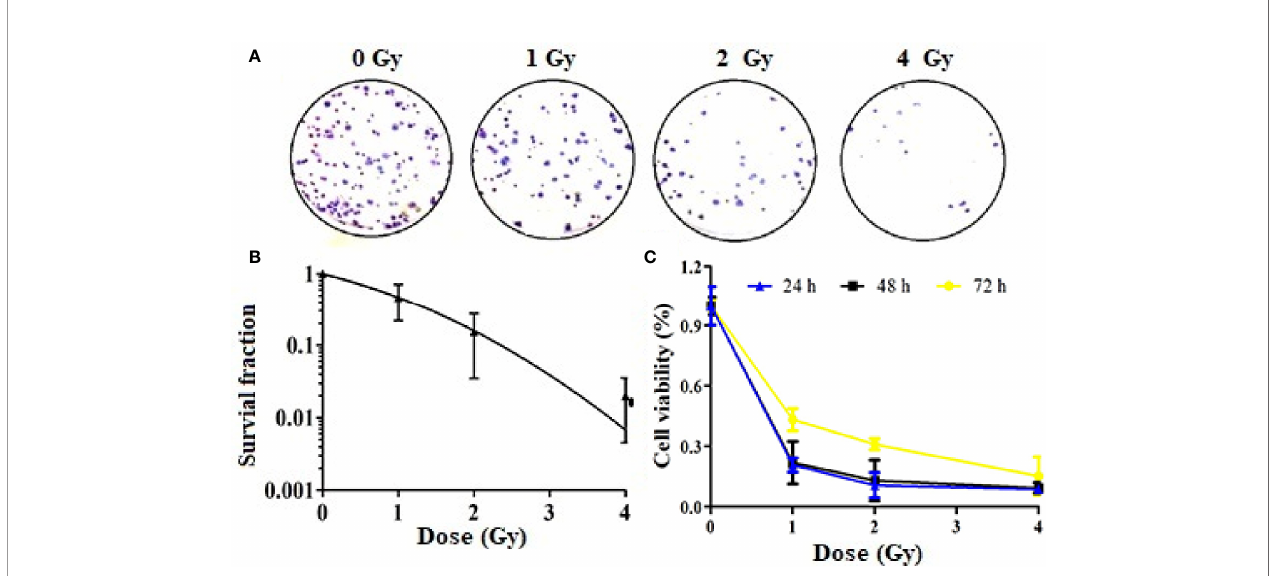
FIGURE 1 | Inhibition of Colony formation and proliferation of A549 cells by carbon ions [ (A) colony formation, (B) survival fraction, (C) inhibition of cell